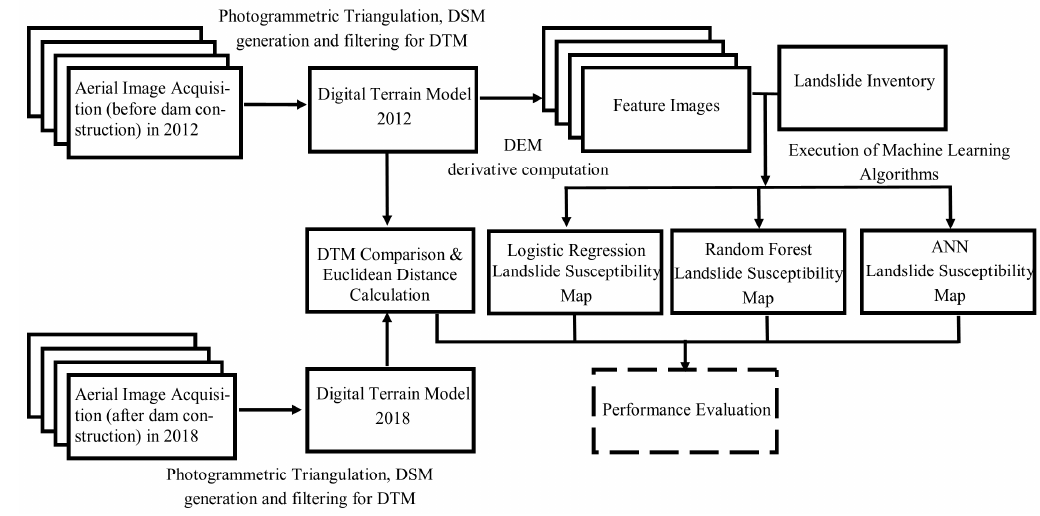
Figure 3. Overall workflow of the methodology.